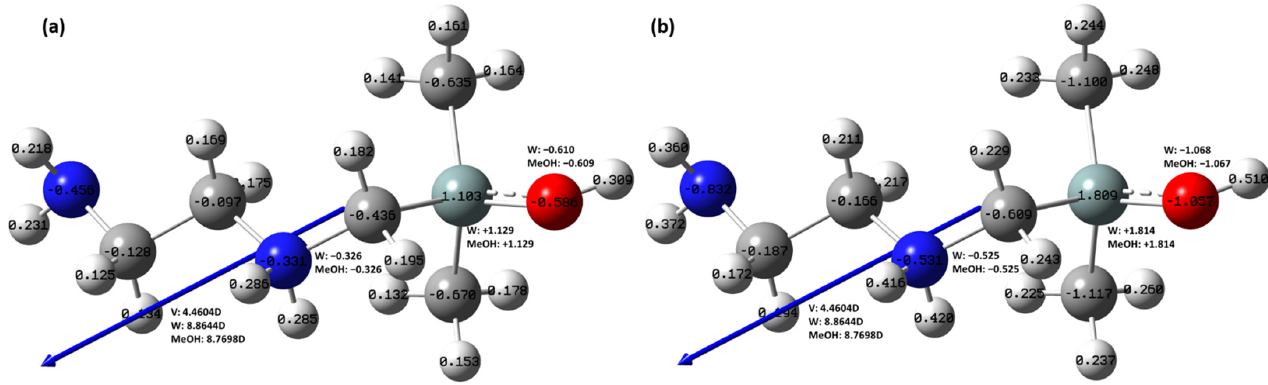
Figure 8. Partial charges for H-silanol: ( a ) Mulliken, ( b ) NPA from NBO; implicit solvents: W—water, MeOH—methanol, V—vacuum.